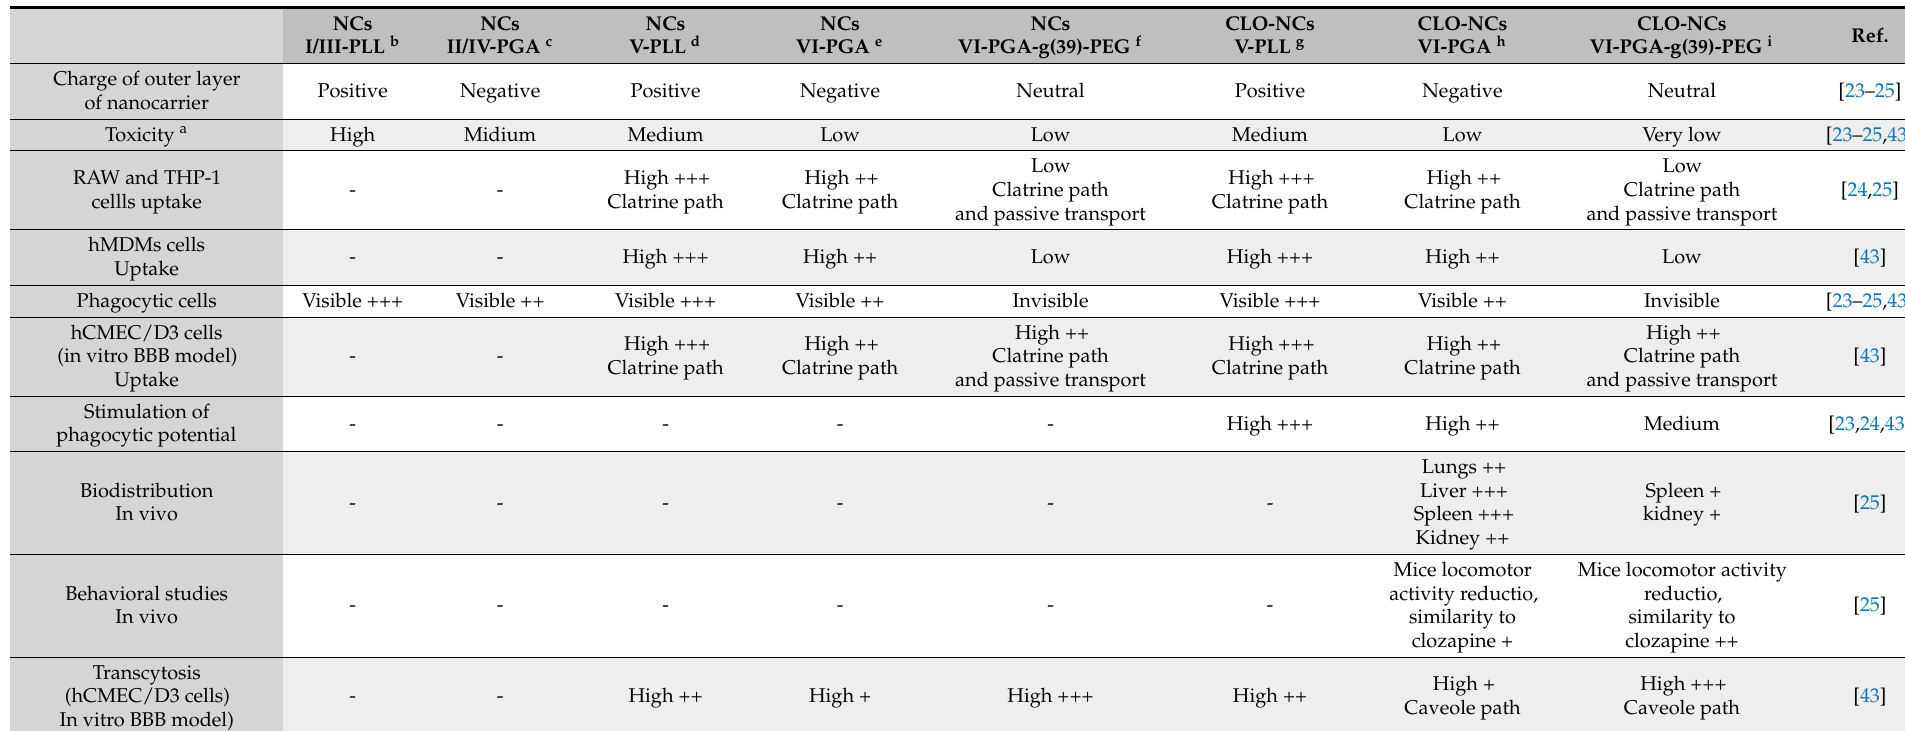
Table 1. Summary of the results obtained for various variants of polymeric nanocapsules (NCs) constituting a new nanocarrier for